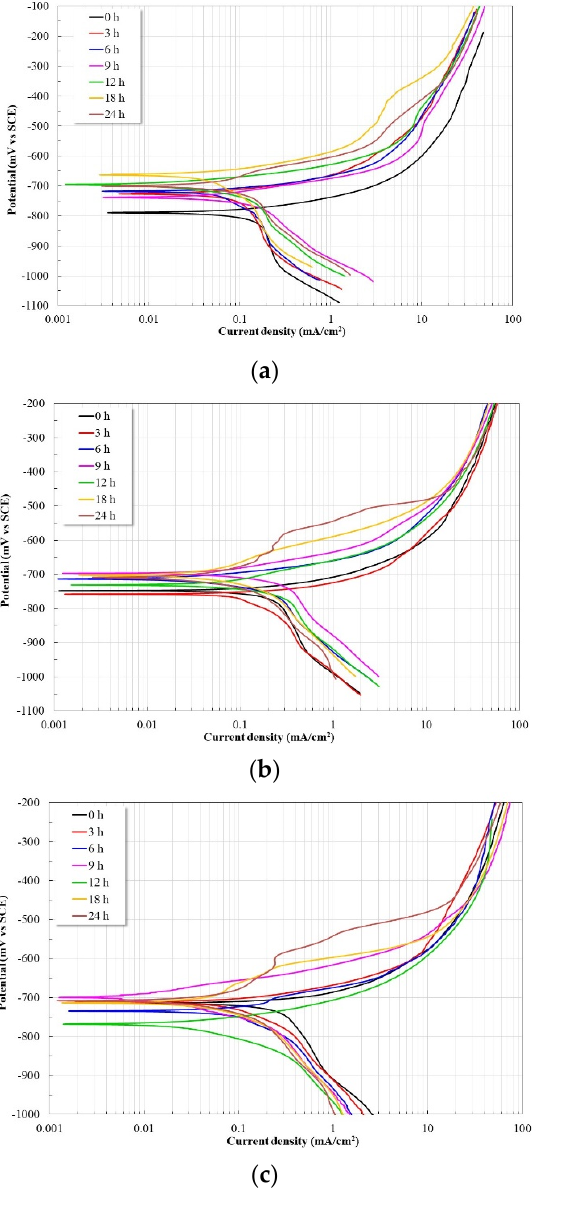
Figure 11. Potentiodynamic polarization curves, as a function of time and temperature, for API-X52 steel in CO 2 -saturated brine, without and with 25 ppm of inhibitor. ( a ) 40 °C, 0 ppm. ( b ) 60 °C, 0 ppm. ( c ) 80 °C, 0 ppm. ( d ) 40 °C, 25 ppm. ( e ) 60 °C, 25 ppm. ( f ) 80 °C, 25 ppm.